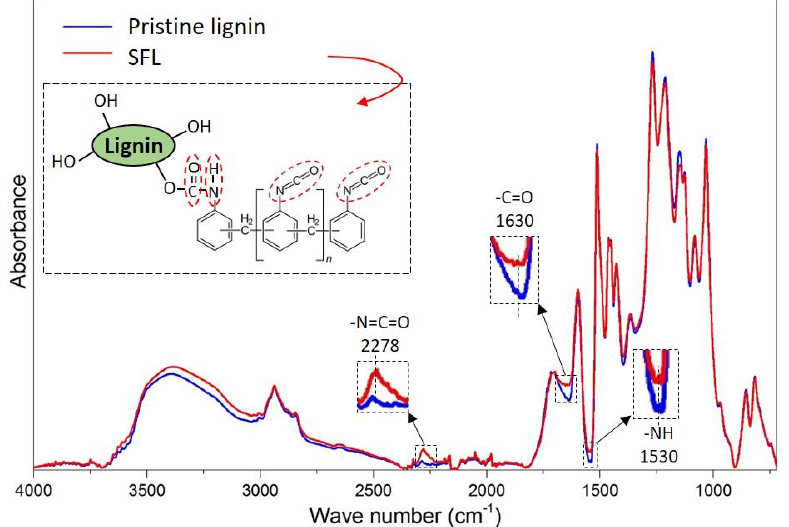
Figure 2. Baseline corrected and normalized Fourier-transform infrared spectroscopy (FTIR) spectra of pristine lignin and SFL.